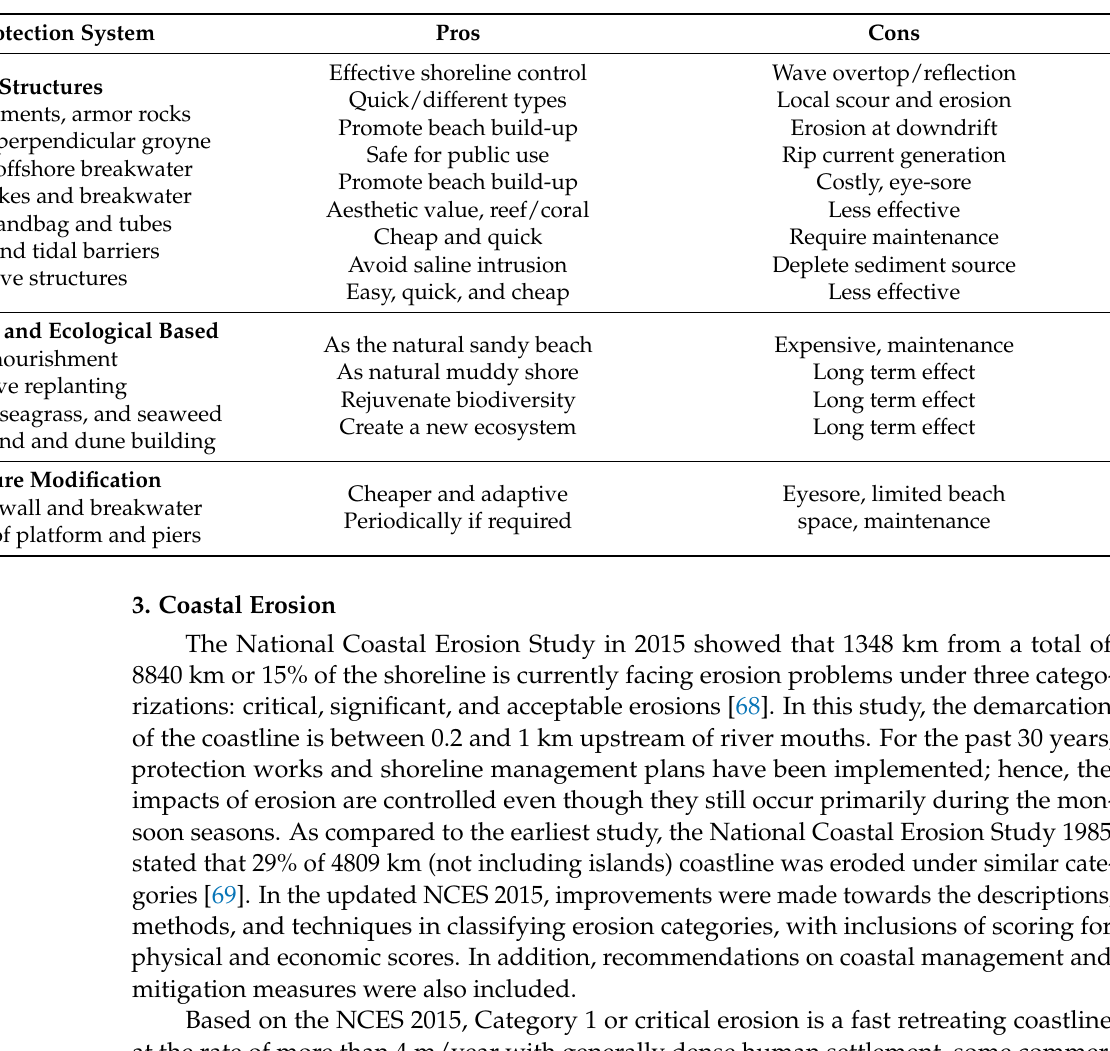
Table 1. General comparison of coastal structures modified from [21]. ‘Reproduced with permission from The manage-ment of coastal erosion [21], 2018; published by Elsevier, License Number 5071160448480, Date 17 May